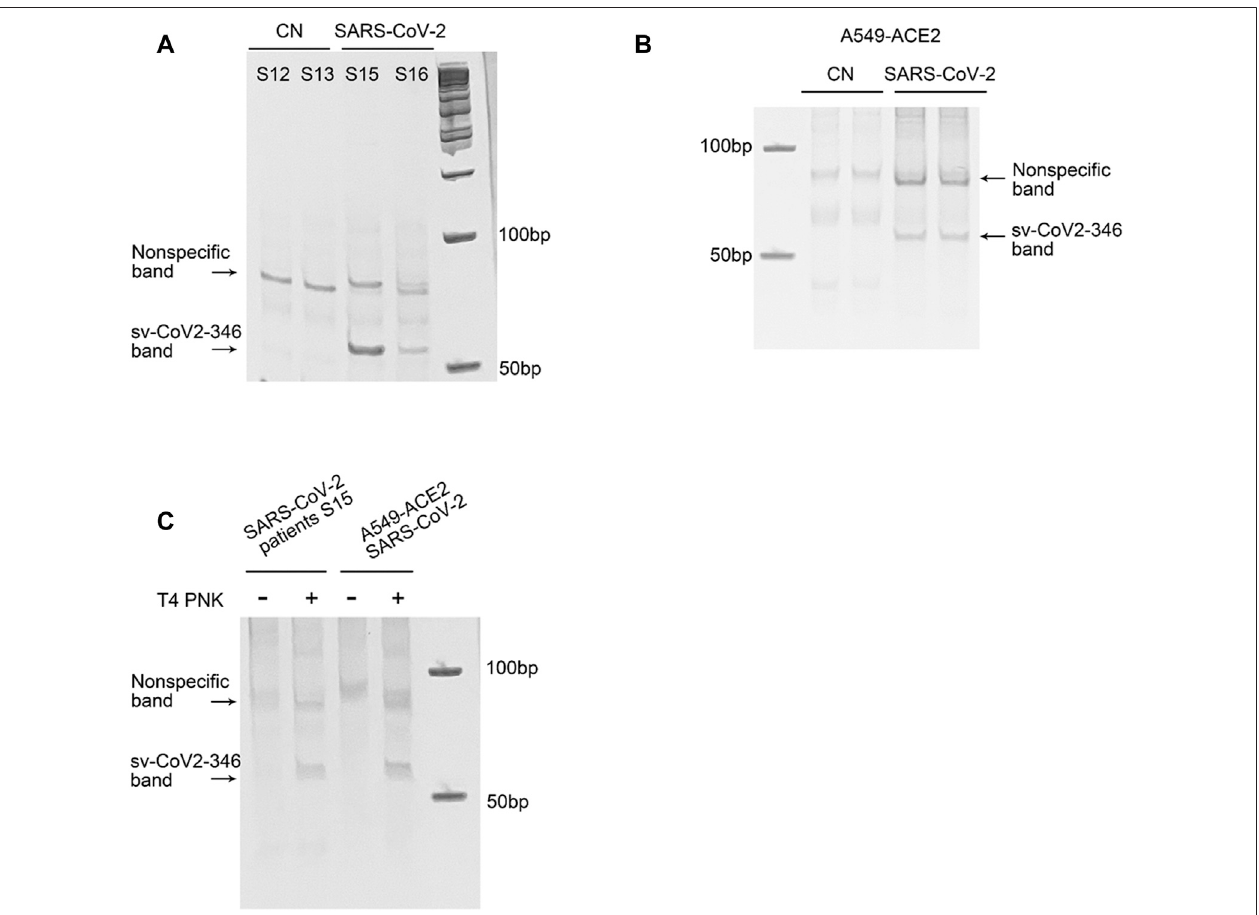
FIGURE 7 | Experimental validation of sv-CoV2-346. (A) RT-PCR was performed to detect sv-CoV2-346 in NPS samples of two control (CN, SARS-CoV-2 negative) and two SARS-CoV-2 patients. (B) The presence of svCoV2-346 in SARS-CoV-2-infected A549-ACE2 cells. (C) Detection of sv-CoV2-346 needs the pretreatment of T4 PNK. The 3 ′ -end of sv-CoV2-346 does not have – OH, as samples without pretreatment of T4 PNK did not result in sv-CoV2-346 bands. All experiments were independently repeated twice.